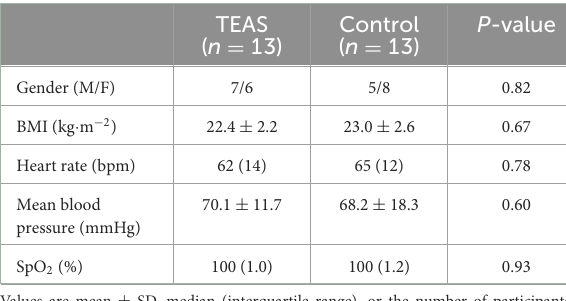
TABLE 1 Demographic parameters and baseline vital signs of the